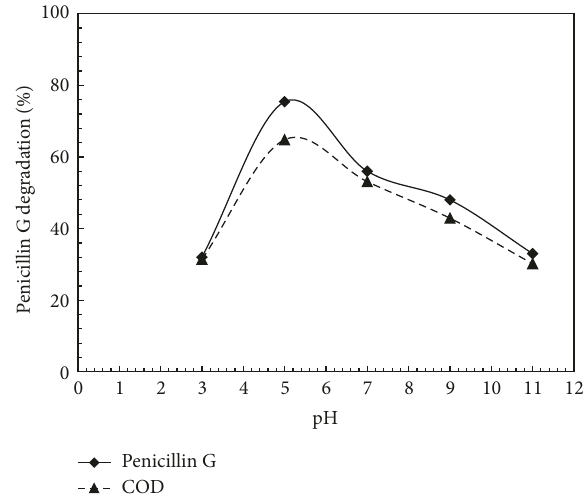
Figure3:EffectofpHonPGandCODdegradationbyUV-activated persulfate. PG = 0.02 mM, time = 60 min, and persulfate = 2